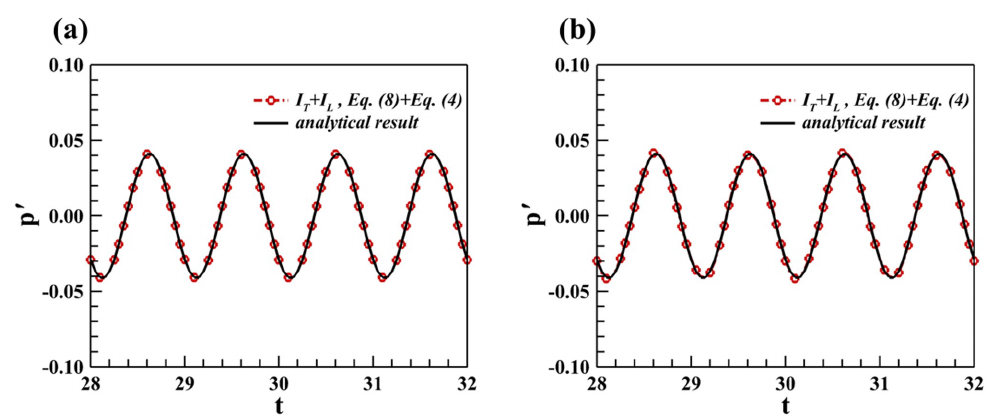
Figure 3. Acoustic pressure calculated by summing Equations (8) and (4) with spurious mass flux on the integral boundary corresponding to ( a ) A e = 10 − 6 m/s and ( b ) A e = 10 − 5